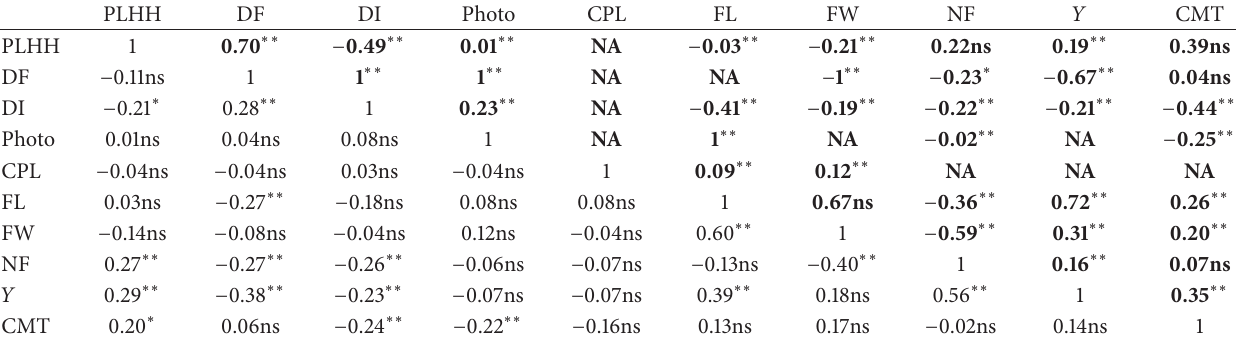
Table 8: Coefficient of phenotypic and genotypic (bold) correlations among the investigated traits in 36 Capsicum spp .